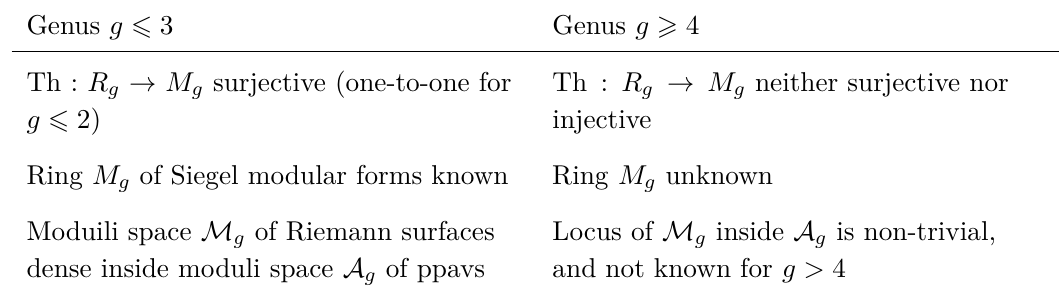
Table 3. Summary of the differences between genus g 6 3 and higher